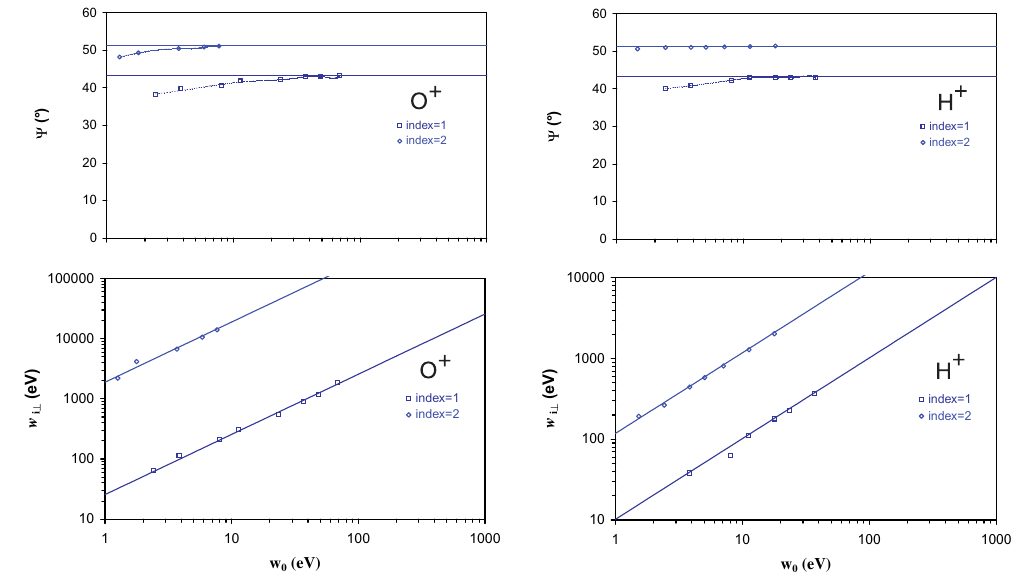
Fig. 12. Evolution of O + (left) and H + (right) apex (top) and mean perpendicular energy (bottom) as functions of w 0 at the poleward heating boundary and at an altitude of 3 R E . Squares and diamonds are associated with a spectral index α = 1 and α = 2, respectively. The solid curves are associated with the analytic formulas from the 1-D theory.